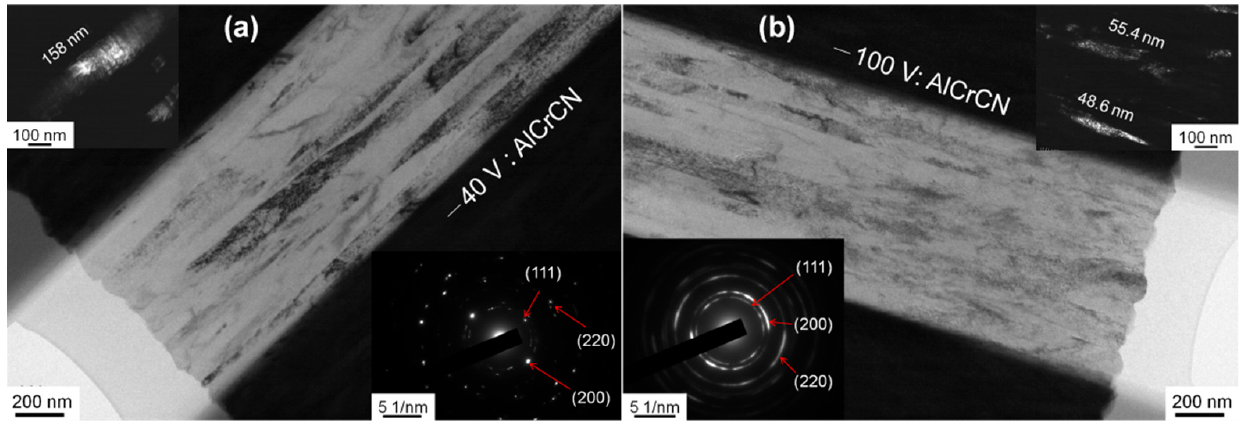
Figure 7. BF, SAED ( a lower right and b lower left) and DF TEM ( a top left and b top right) images of AlCrCN film as a function of bias voltage ( − 40 V and − 100 V).